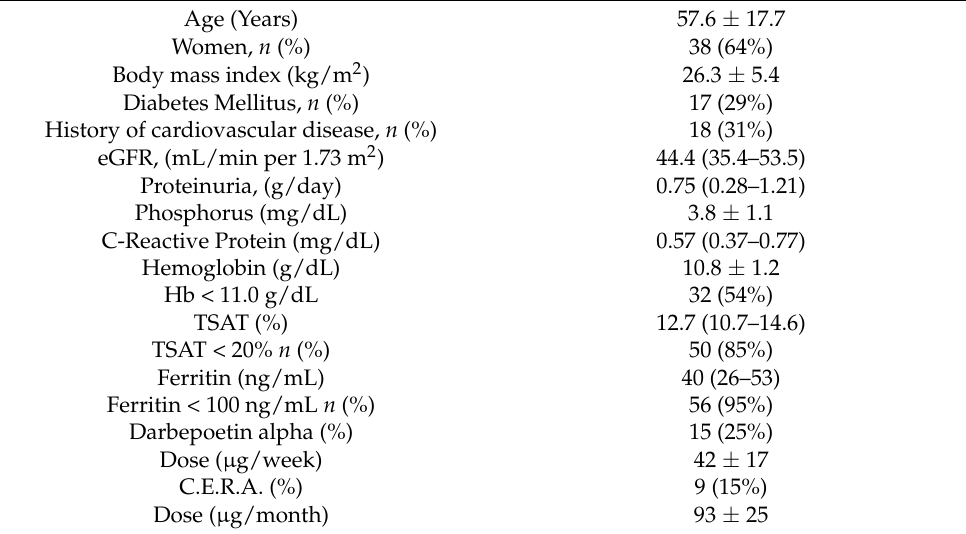
Table 2. Baseline clinical characteristics of patients.